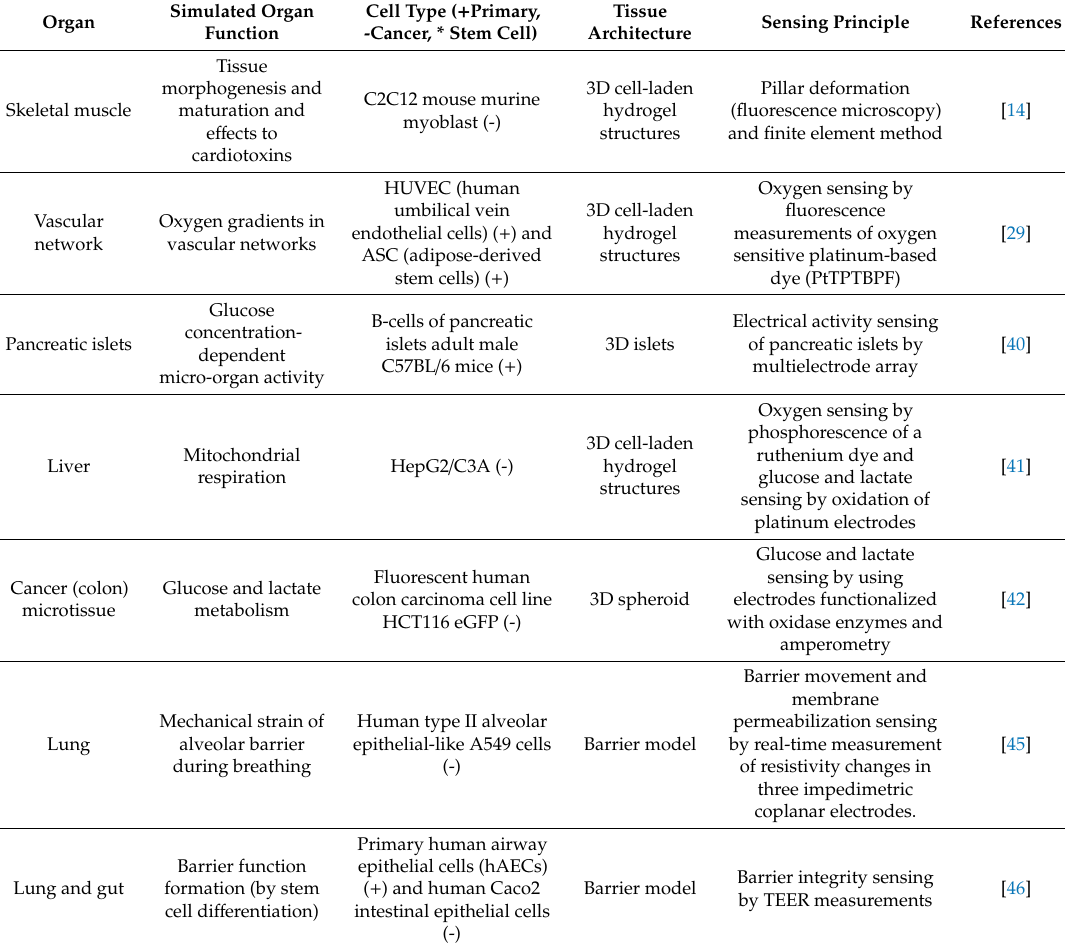
Table 1. Overview of organs-on-a-chip and microphysiological systems with integrated biosensors.